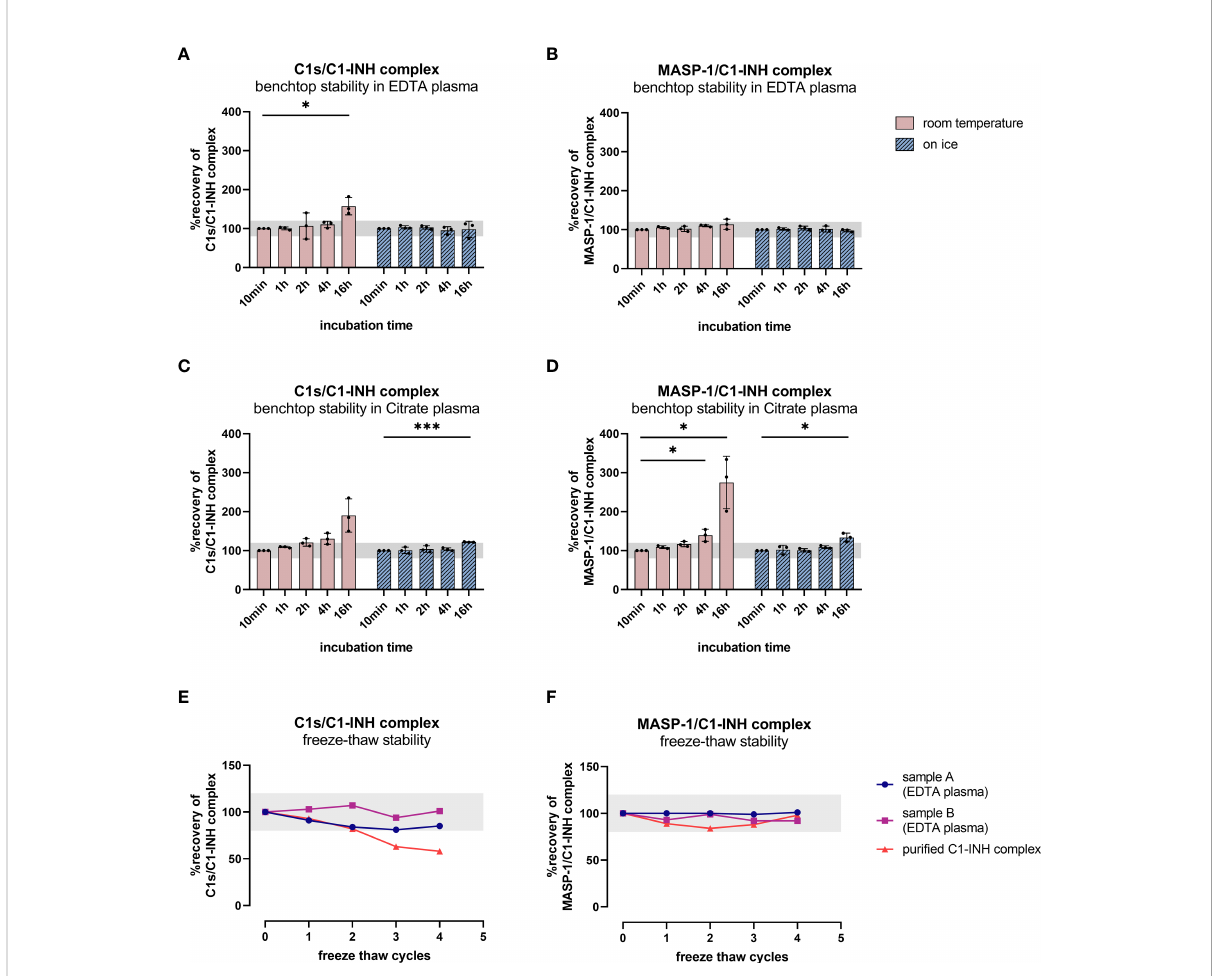
FIGURE 7 Benchtop stability of C1-INH complexes in EDTA plasma and Citrate plasma (A – D) and freeze-thaw stability of complexes in EDTA plasma and in puri fi ed form (E, F) . For benchtop testing (panels A – D ), samples were stored at room temperature (red graphs) or on ice (blue graphs) for different time intervals (10 min-16 h). Afterwards concentrations of either C1s/C1-INH complex ( A : EDTA plasma, C : Citrate plasma) or MASP-1/ C1-INH complex ( B : EDTA plasma, D : Citrate plasma) were measured in the samples. C1-INH concentrations of the 10 min samples were set as 100% and the amount of complexes at other time points was calculated in relation to the 10 min sample. Differences to the 10 min sample were calculated using one sample t-test (* p<0.05, *** p<0.001, non-signi fi cant results are not marked). Due to natural variation in biomarker measurements, acceptable concentrations ranged from 80-120% compared to the concentration in the respective 10 min sample. For analysis of freeze-thaw stability (panels E, F ), aliquots of either puri fi ed C1-INH complex (plotted in red) or two independent EDTA plasma samples (plotted in blue and pink) were exposed to 0 to 4 freeze-thaw cycles and concentrations of C1s/C1-INH complex (E) and MASP-1/C1-INH complex (F) were determined in the respective sandwich ELISAs. Due to natural variation when measuring biomarkers, acceptable complex concentrations ranged from 80-120% of the original concentration (0 freeze thaw cycles) and the accepted range is marked in grey on the fi gures. min, minutes; h, hours; EDTA, ethylenediaminetetraacetic